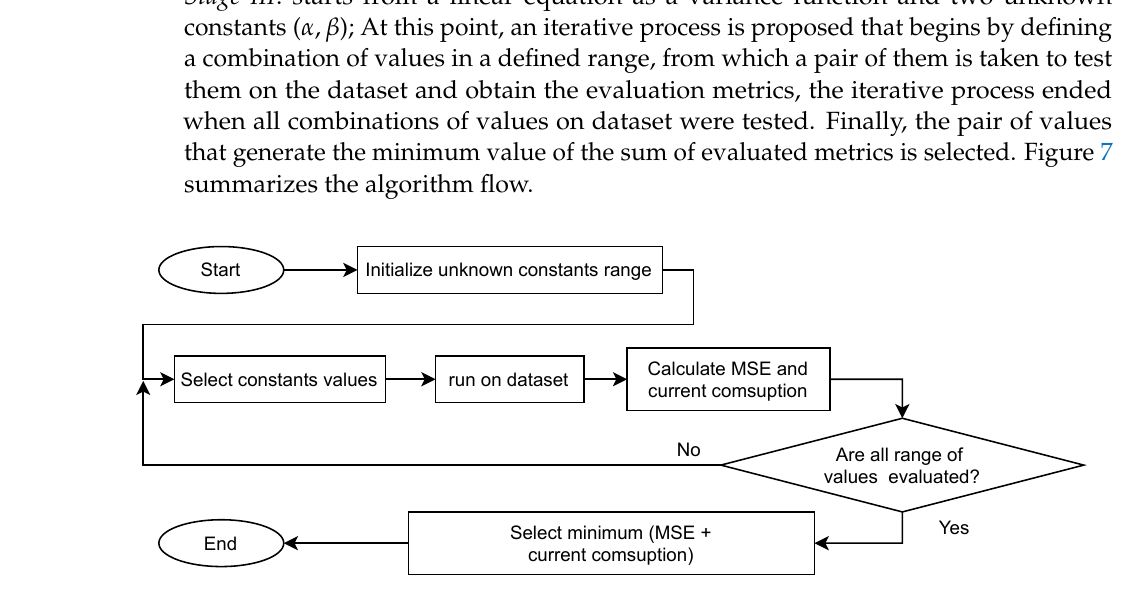
Figure 7. Flow chart to find the best constant